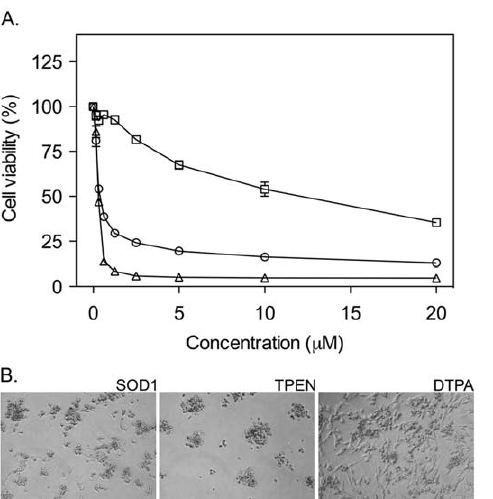
Figure 6. Zn 2 + chelators induce a toxic response similar to that of apoSOD1. The high-affinity Zn 2 + chelators TPEN and DTPA were dissolved in DMSO and added to SH-SY5Y cells in parallel with monomeric apoSOD1 in a concentration range of 0.16 to 20 m M, and incubated for 72 h before addition of MTT. The final concentration of DMSO in the cell culture was 0.1%. ( A ) TPEN ( n ) induces a toxic response similar to that of monomeric apoSOD1 ( # ), whereas DTPA ( % ) shows an overall weaker effect. Chelators and apoSOD1 protein were added in duplicate and data are presented as mean percentage of vehicle control 6 range. ( B ) Phase contrast images of cells exposed to 10 m M monomeric apoSOD1, 10 m M TPEN and 10 m M DTPA. Cells incubated with apoSOD1 closely resemble cells incubated with TPEN.